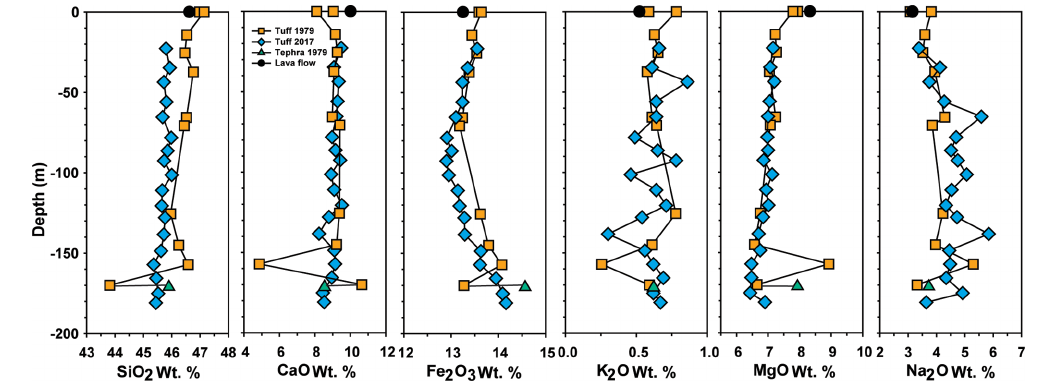
Figure 4. Whole-rock geochemical compositions, 1979 core archive, and 2017 SE-02b reference samples (Table S3) following the methods of Rhodes and Vollinger (2004).